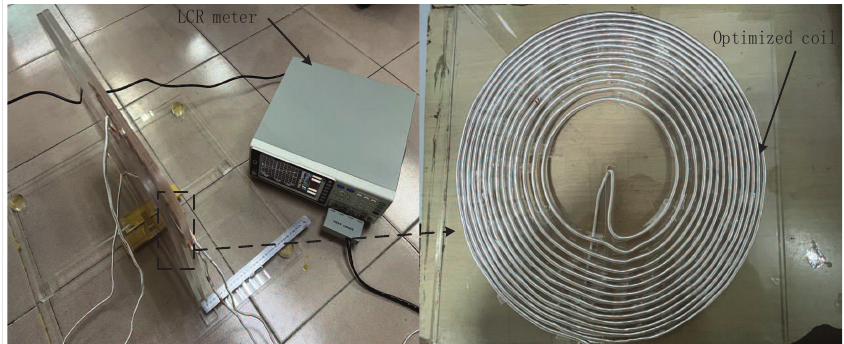
Figure 10. Experimental